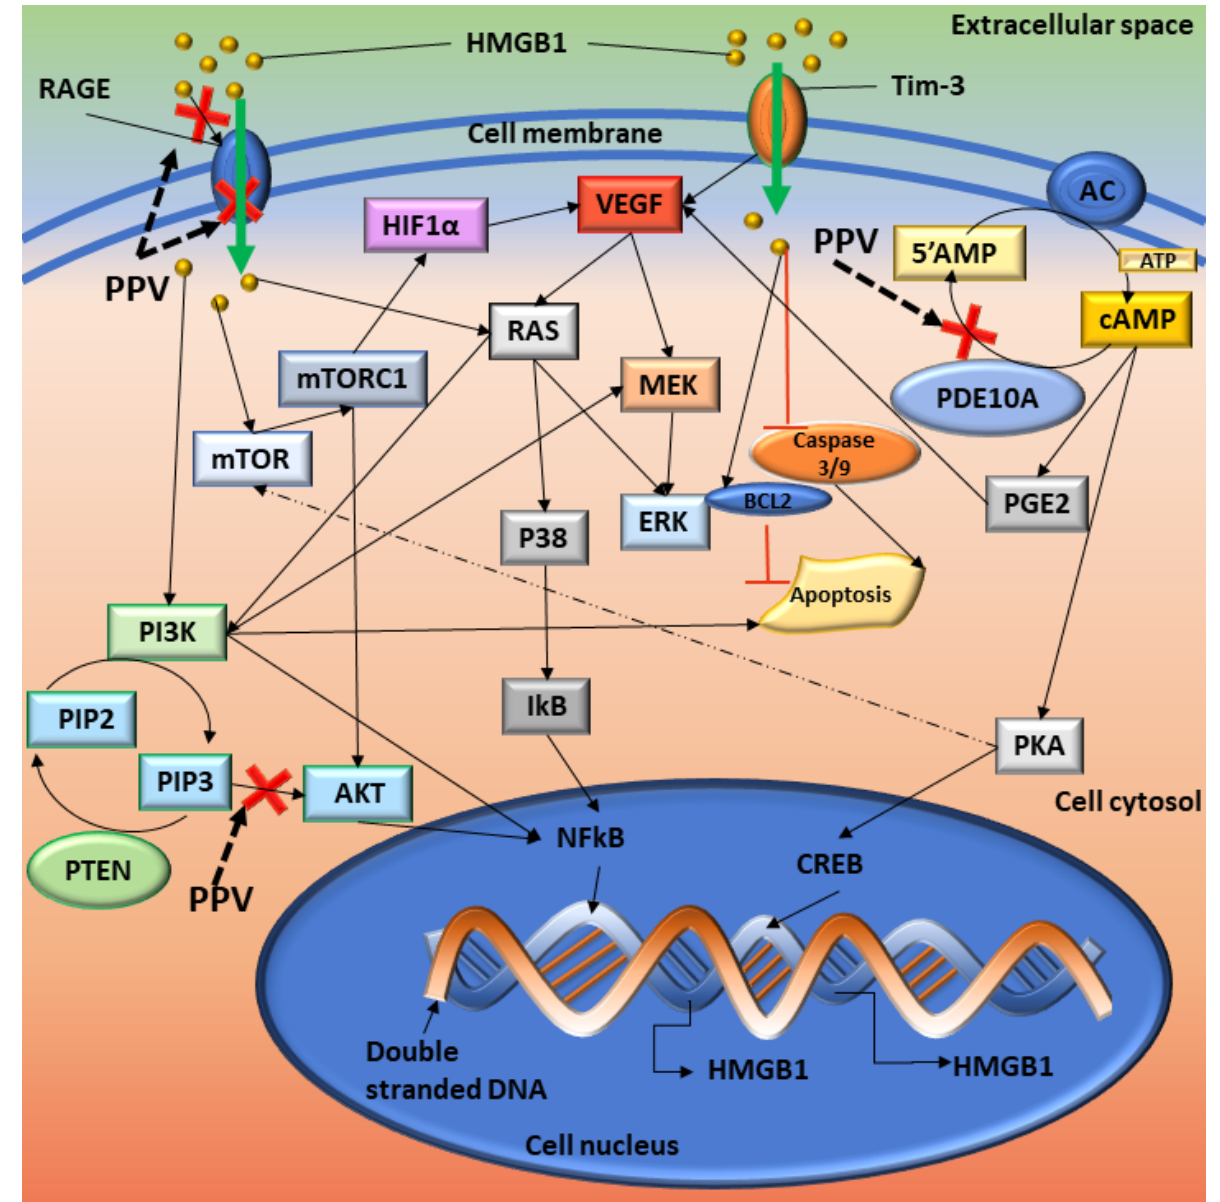
Figure 9. Summary of the proposed cellular signalling affected by PPV. Red crosses indicate the possible sites where PPV exerts its effects. Solid black arrows indicate the pathways and dotted arrows indicate a possible interaction. HMGB1 interacts with RAGE which induces cellular signals that affect several pathways. Once NF-kB is activated, it translocates to the nucleus where it interacts with DNA and upregulates the transcription of several genes, including HMGB1 and TNF. The interaction of HMGB1 with T Cell immunoglobulin mucin–3 (TIM-3) induces the secretion of VEGF to promote tumour angiogenesis, an immunoregulatory protein. VEGF can then stimulate MEK, which leads to ERK activation. AC controls the formation of cAMP from 5 ′ AMP, and PDE10A degrades cAMP back into 5 ′ AMP. Inhibition of PDE10A can lead to the build-up of cAMP, which increases the available levels of PKA and PGE2. PKA can then upregulate CREB, which increases the transcription of several downstream molecules, including HMGB1, and surviving. HMGB1 can inhibit the caspase 3/9 pathway, releasing proapoptotic inhibitors such as BAX and controls the protein levels of Bcl-2 [53,54]. Image designed by DA Gomes using Microsoft ® Office PowerPoint (Microsoft Office enterprise 2007, 2006 Microsoft Corporation, Redmond, WA, USA).